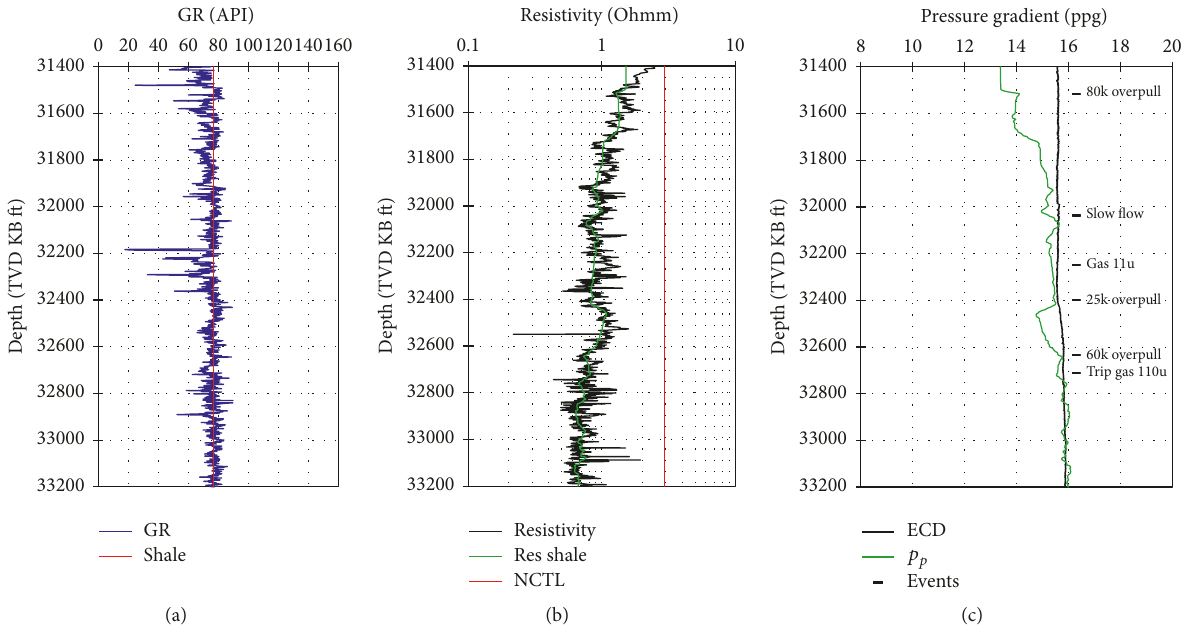
Figure 4: Real-time pore pressure detection from LWD resistivity. (a) shows the real-time gamma ray and shale lines; (b) presents the resistivity (red curve), picked shale resistivity (green curve), and NCT (red line); (c) plots the real-time calculated pore pressure (green curve), ECD, and drilling events (overpull, well influx, and mud gas